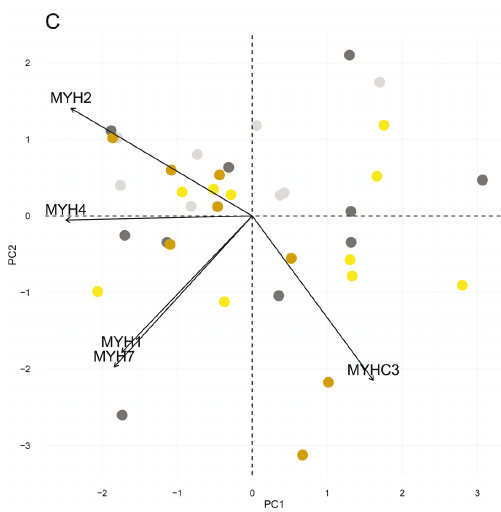
Figure 3. Principal component analysis-biplot of individual pigs and myosin heavy chain isoforms. Expression data of MYH1 , MYH2 , MYH3 , MYH4 , and MYH7 was used to describe differences among individual pigs affiliated with CON-males ( light gray ), CON-females ( dark gray ), MET-males ( yellow) , and MET-females ( orange ) at ( A ) 63 dpc, ( B ) 91 dpc, and ( C ) 152 dpn, respectively.